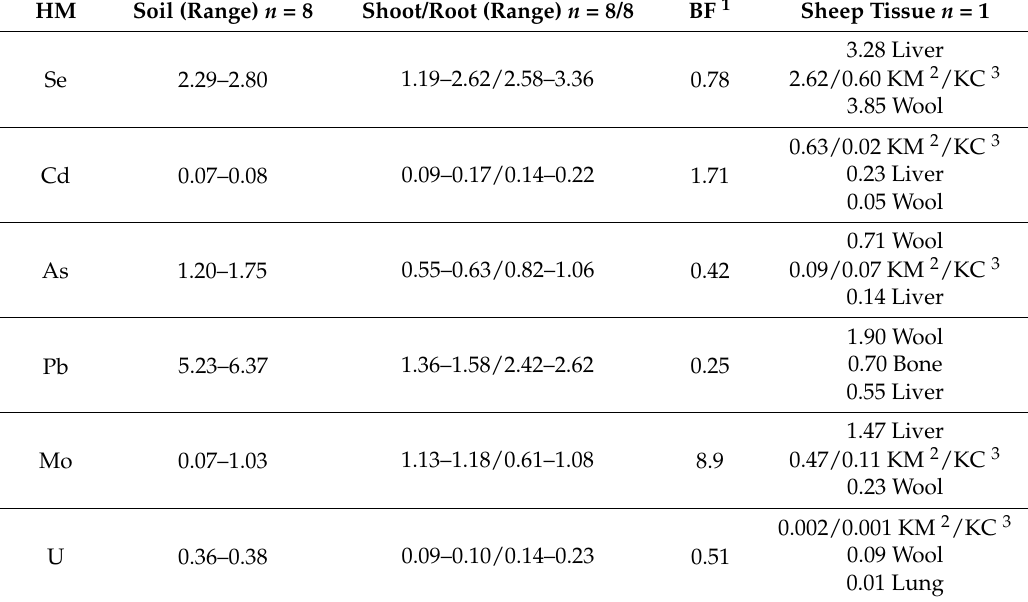
Table 5. Sheep 3 heavy metal concentrations in soil, forage, bioaccumulation factor ratio, and sheep tissue in mg/kg, dry